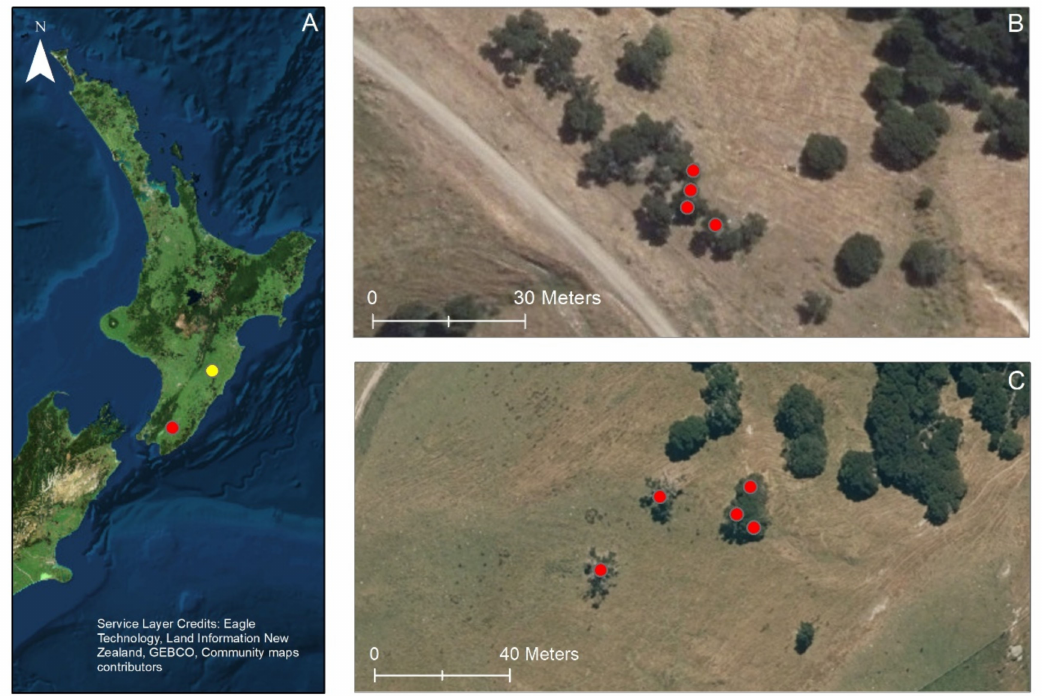
Figure 1. Study site locations and individual trees evaluated at each site. ( A ): Location of the study sites in New Zealand (the red dot is the Wairarapa site and the yellow dot is the Hawkes Bay site). ( B ): The studied k¯anuka trees at the Wairarapa site (red dots show the individual trees evaluated). ( C ): The studied k¯anuka trees at the Hawkes Bay site (red dots show the individual trees evaluated). ( B , C ) are from the same satellite layer as ( A